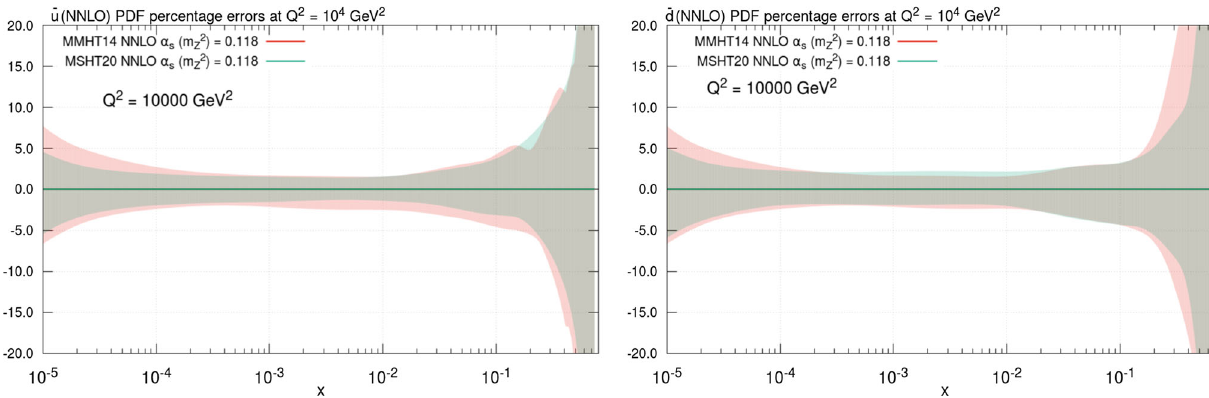
low rapidity is a very direct constraint on u V − d V , see